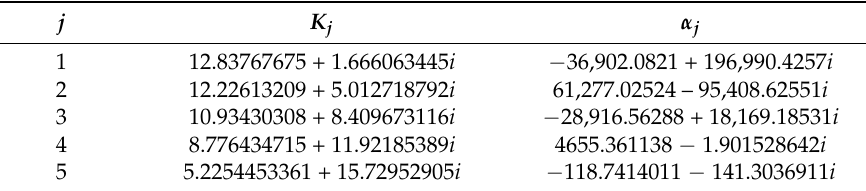
Table 1. The values of K j and α j for the Zakian method